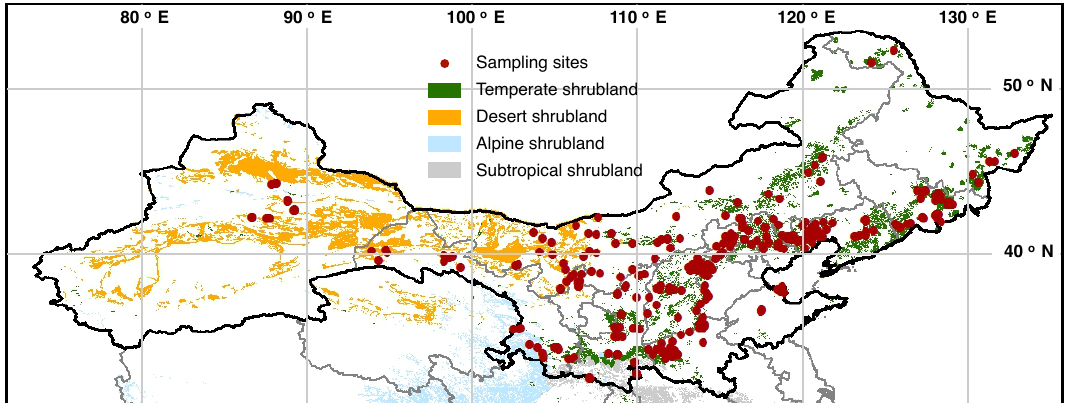
Figure 1. Locations of the sampling sites based on shrublands in northern China.